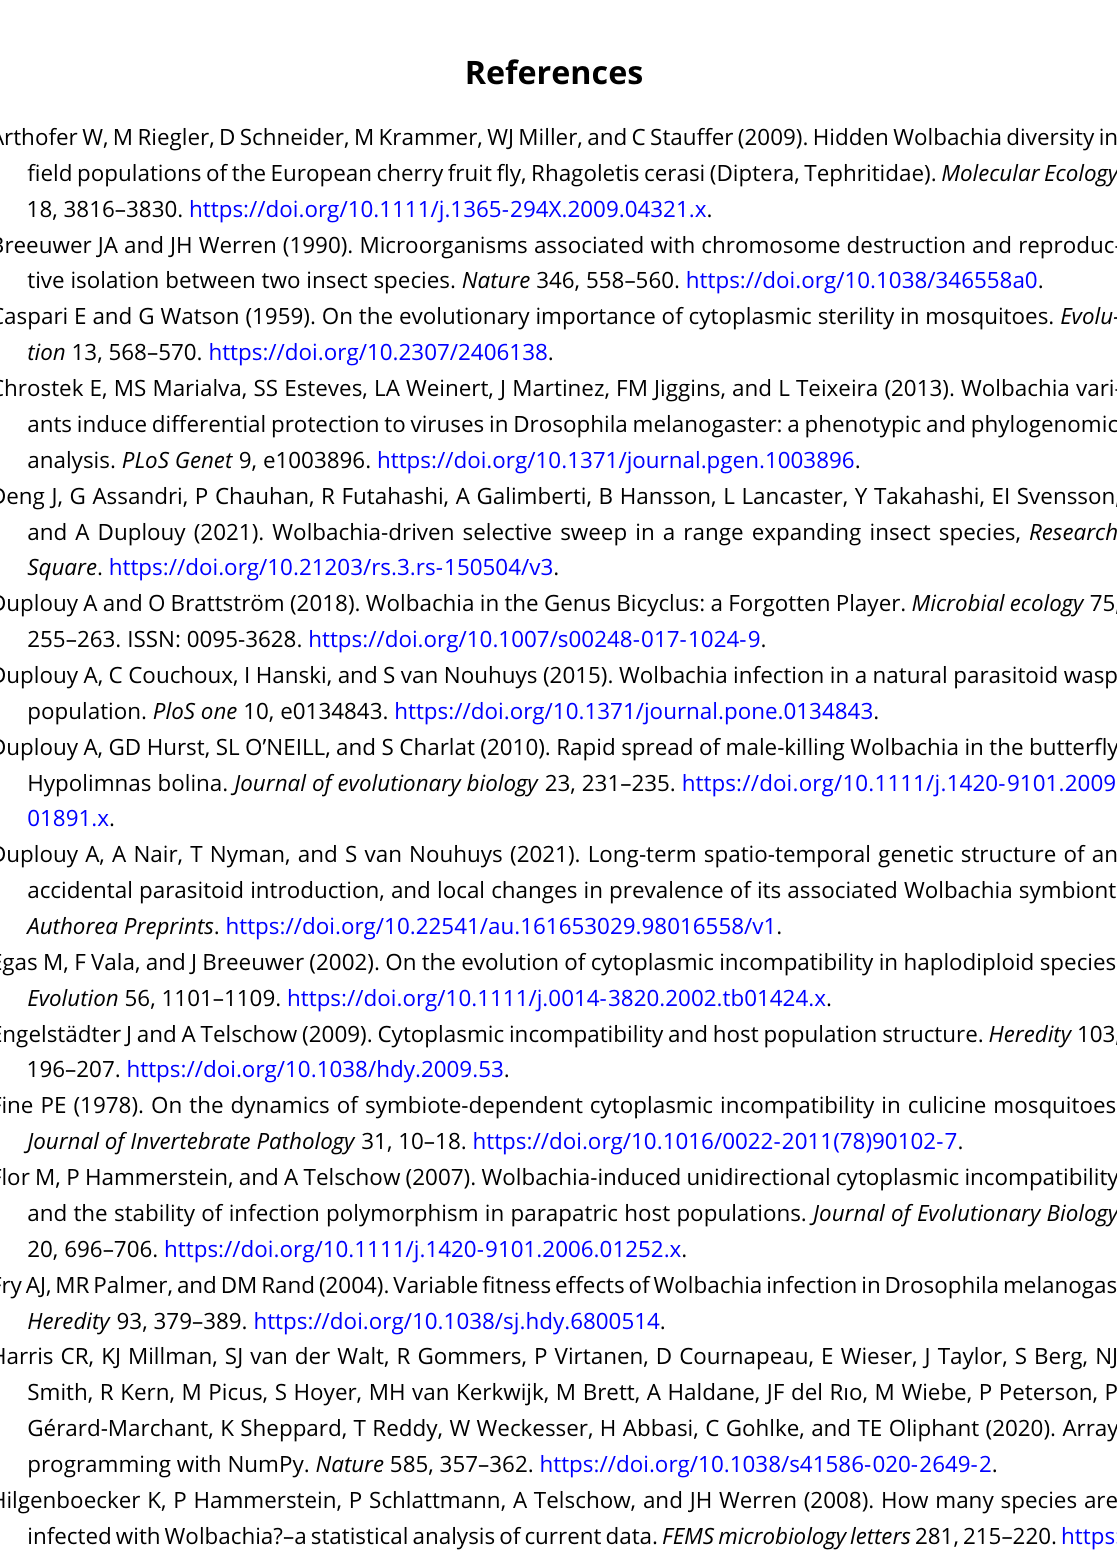
The right-hand side above is never below zero for any valid parameter values, and therefore than one. Hence, the female infection frequency is always higher than or equal to the male infection